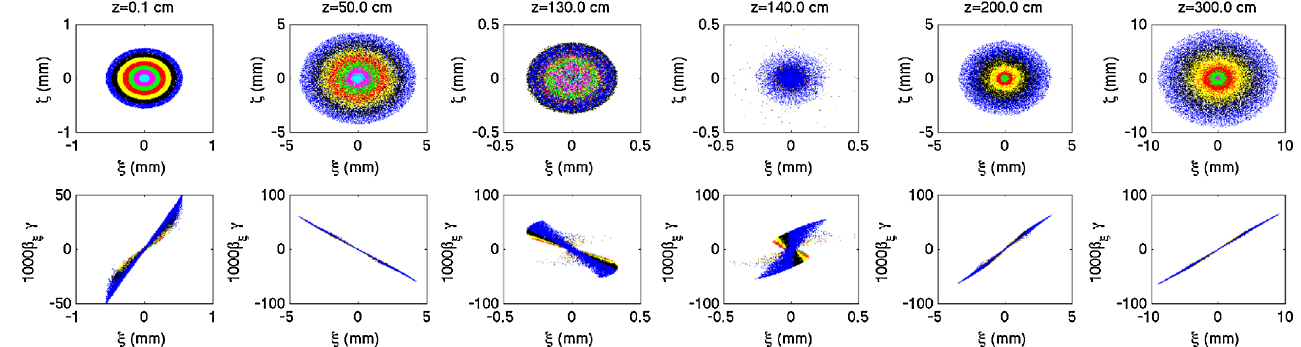
FIG. 10. (Color) Macroparticle distributions in the transverse configuration space (top) and transverse horizontal phase space (bottom) at different locations from the photocathode surface ( z ¼ 0 : 1 , 50, and 130, 140, 200, and 300 cm from left to right columns) associated to the central beamlet without the peripheral beamlets. The peak B-field of L3 is ^ B ¼ 0 : 376 T . The coordinate system is the Larmor frame ð (cid:10); (cid:11) Þ . The color coding corresponds to different radial slices at the emission time (the beam at emission was divided into seven radial slices of same thickness (cid:7)r ’ 70 (cid:1) m ).